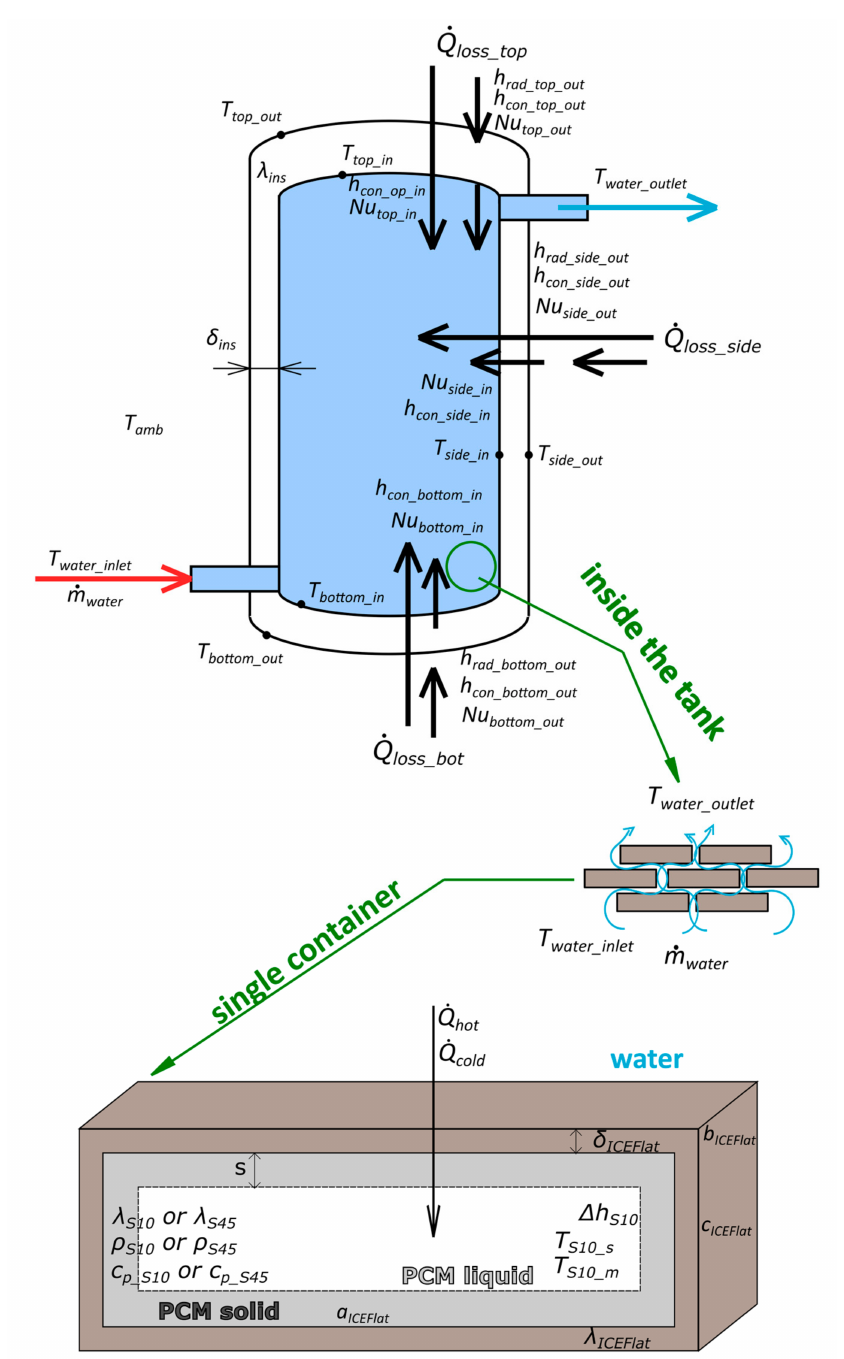
Figure 2. Scheme of the PCM storage tank with marked physical parameters describing the thermal